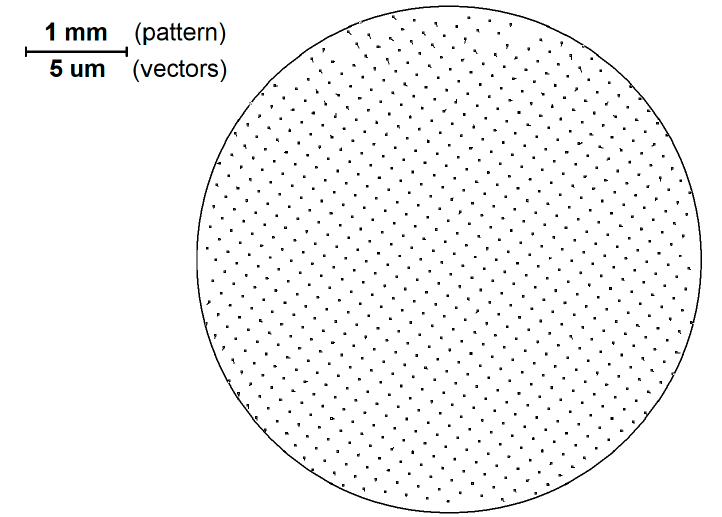
Figure 7. Image of the vector field after performing the correction using distortion and pattern displacements correction data (enlarged 200 times compared to the scale of the pattern).